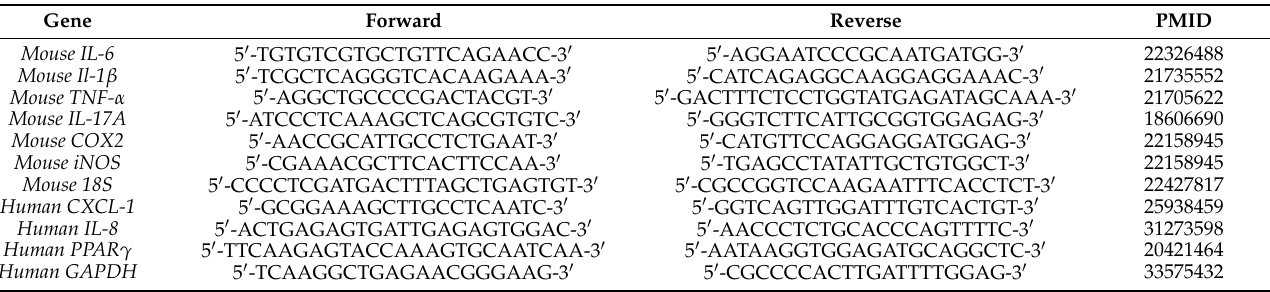
Table 2. Primer sequences used for real-time